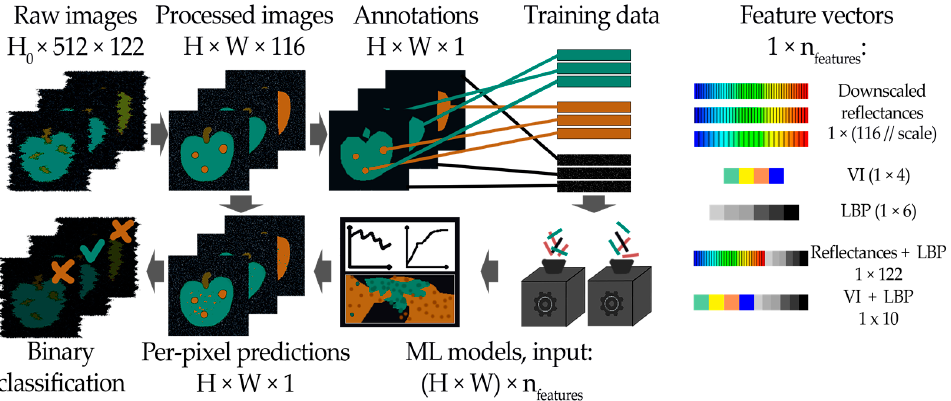
Figure 2. An overview of the classification pipeline. After preprocessing and image registration, both spatial dimensions of spectral images vary; one-hot label encoding is, in effect, used internally during training and inference. during training and